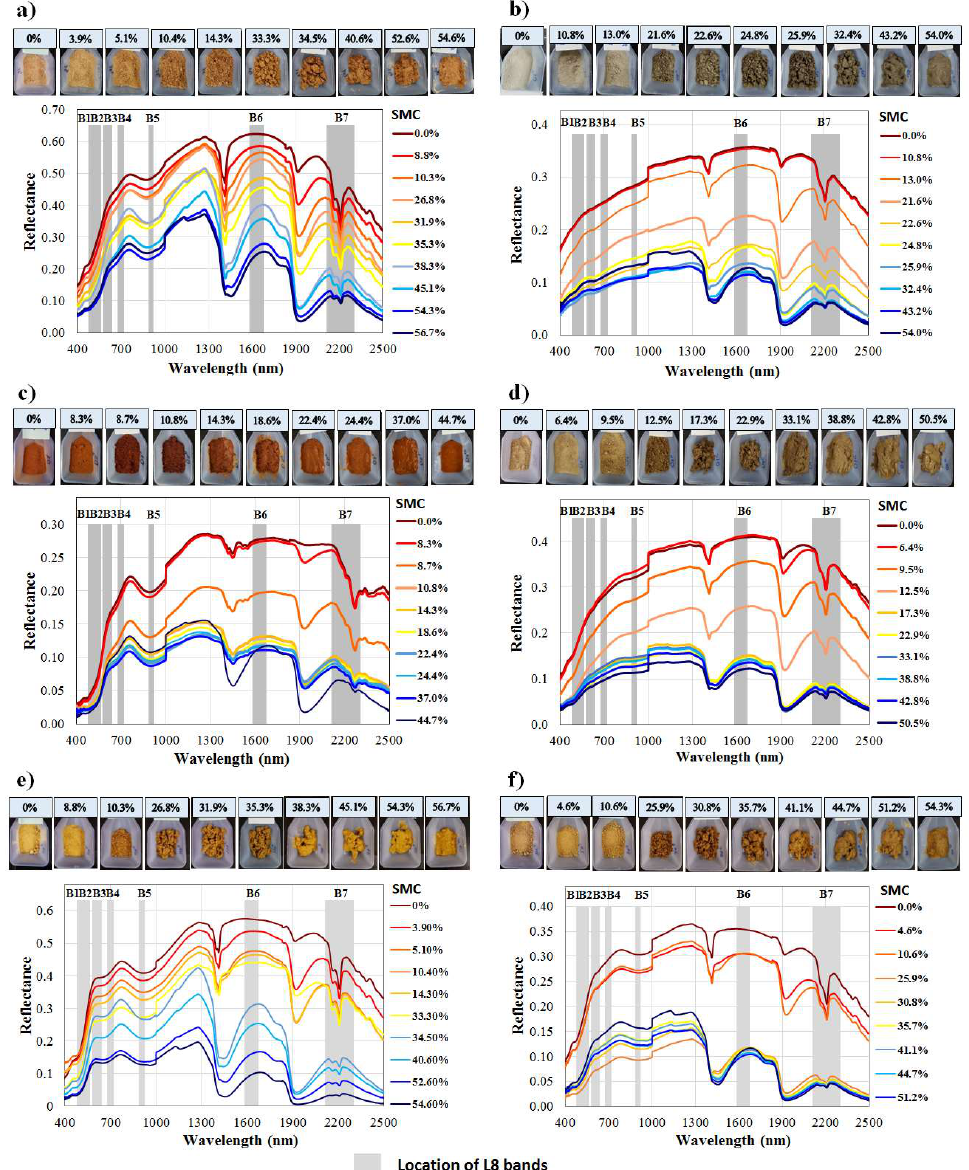
Figure 4. Images of the soil sub-samples, and charts presenting the spectral response to various SMC of six soil samples taken from the northern part of the Central Highlands of Vietnam, indicate the trend showing a lower R rs ( λ ) with higher SMC. The six soil samples in the experiment correspond to the six investigated soil types: ( a ) Acric ferralsols; ( b ) Dystric gleysols; ( c ) Rhothic ferrasols; ( d ) Eutric fluvisols; ( e ) Orthic ferralsols; ( f ) Ferric acrisols.